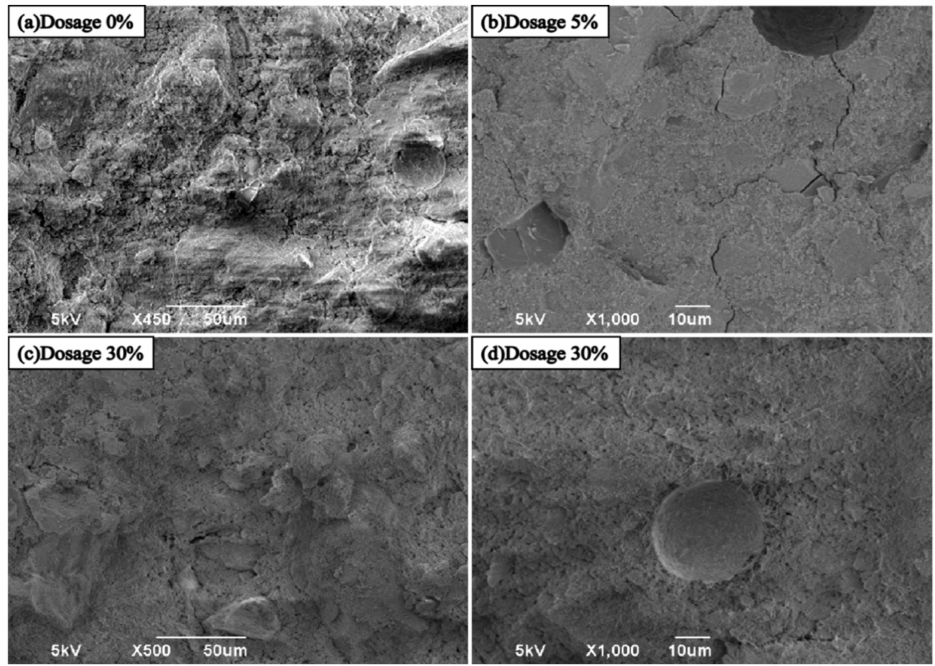
Figure 7. SEM images of MOC after water immersion for 7 days (( a – d ) in the figure represent the incorporation amount of lithium slag as 0%, 5%, 30% and 30%